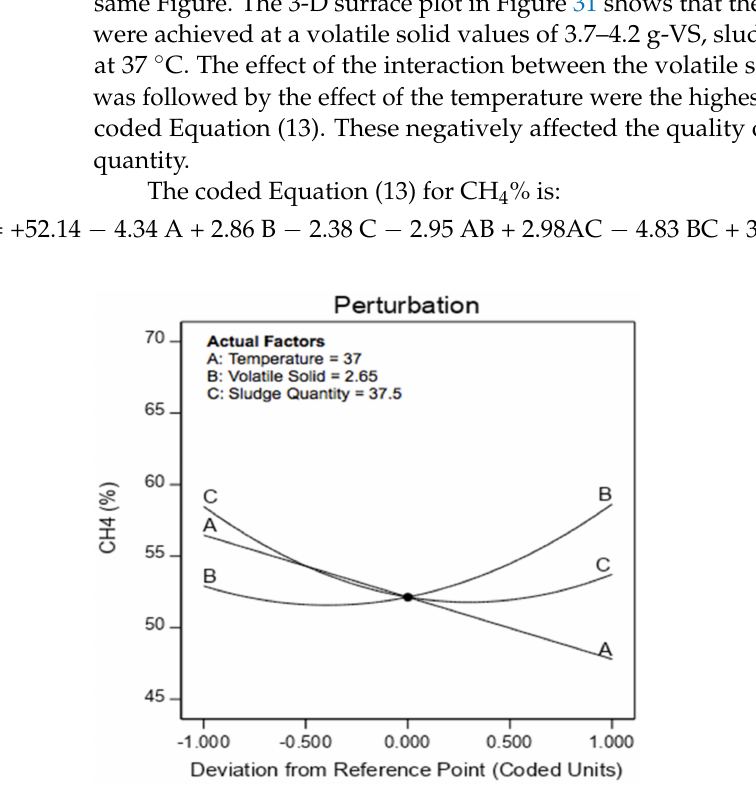
Figure 27. Perturbation plot clarifies the effect of all factors on CH 4 %.